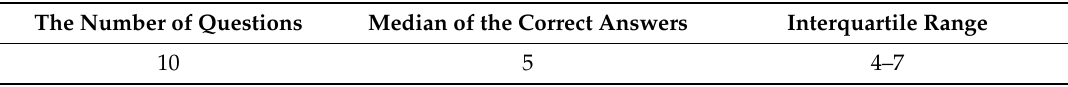
Table 2. Median of the correct answer.